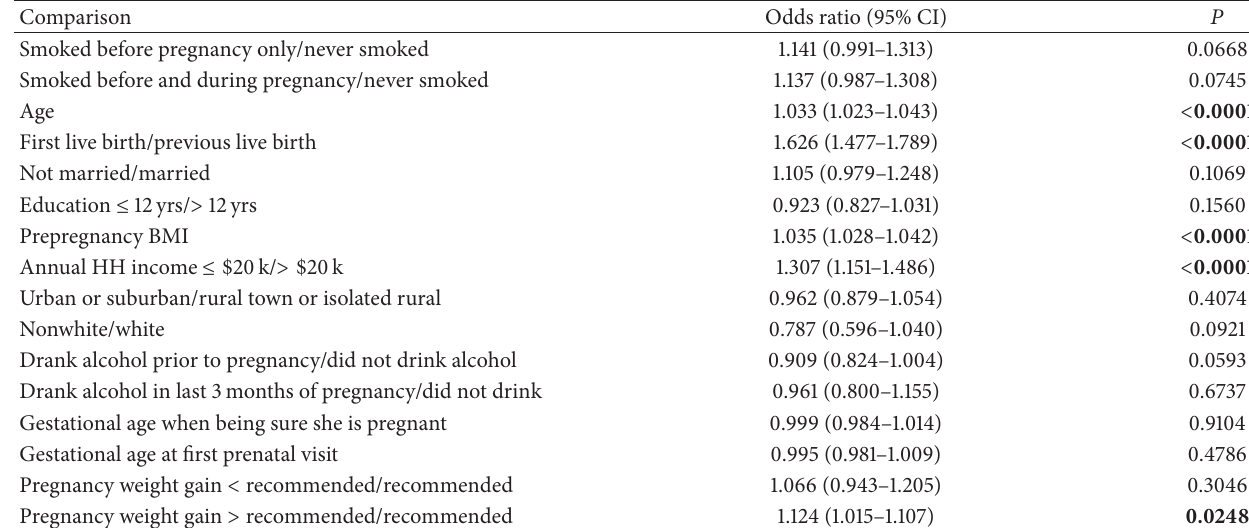
Table 2: Maternal predictors of longer hospital stay by newborn.